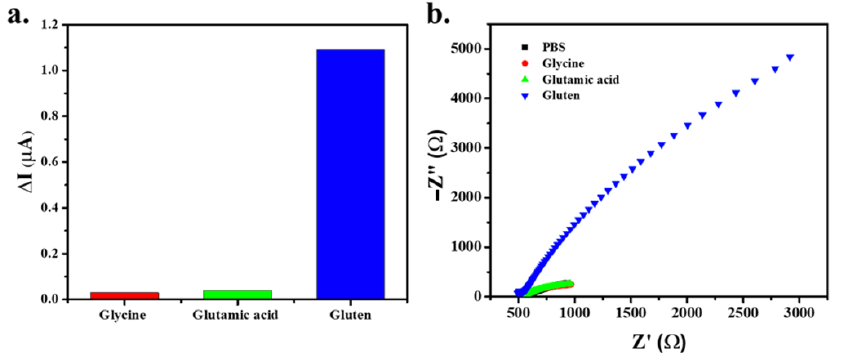
Figure 7. Current ( a ) and resistance response ( b ) of the gluten, as measured by the MMIP-modified electrode.